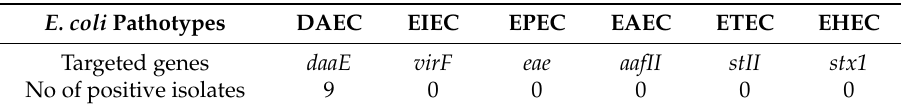
Table 3. Number of confirmed E. coli Pathotypes.